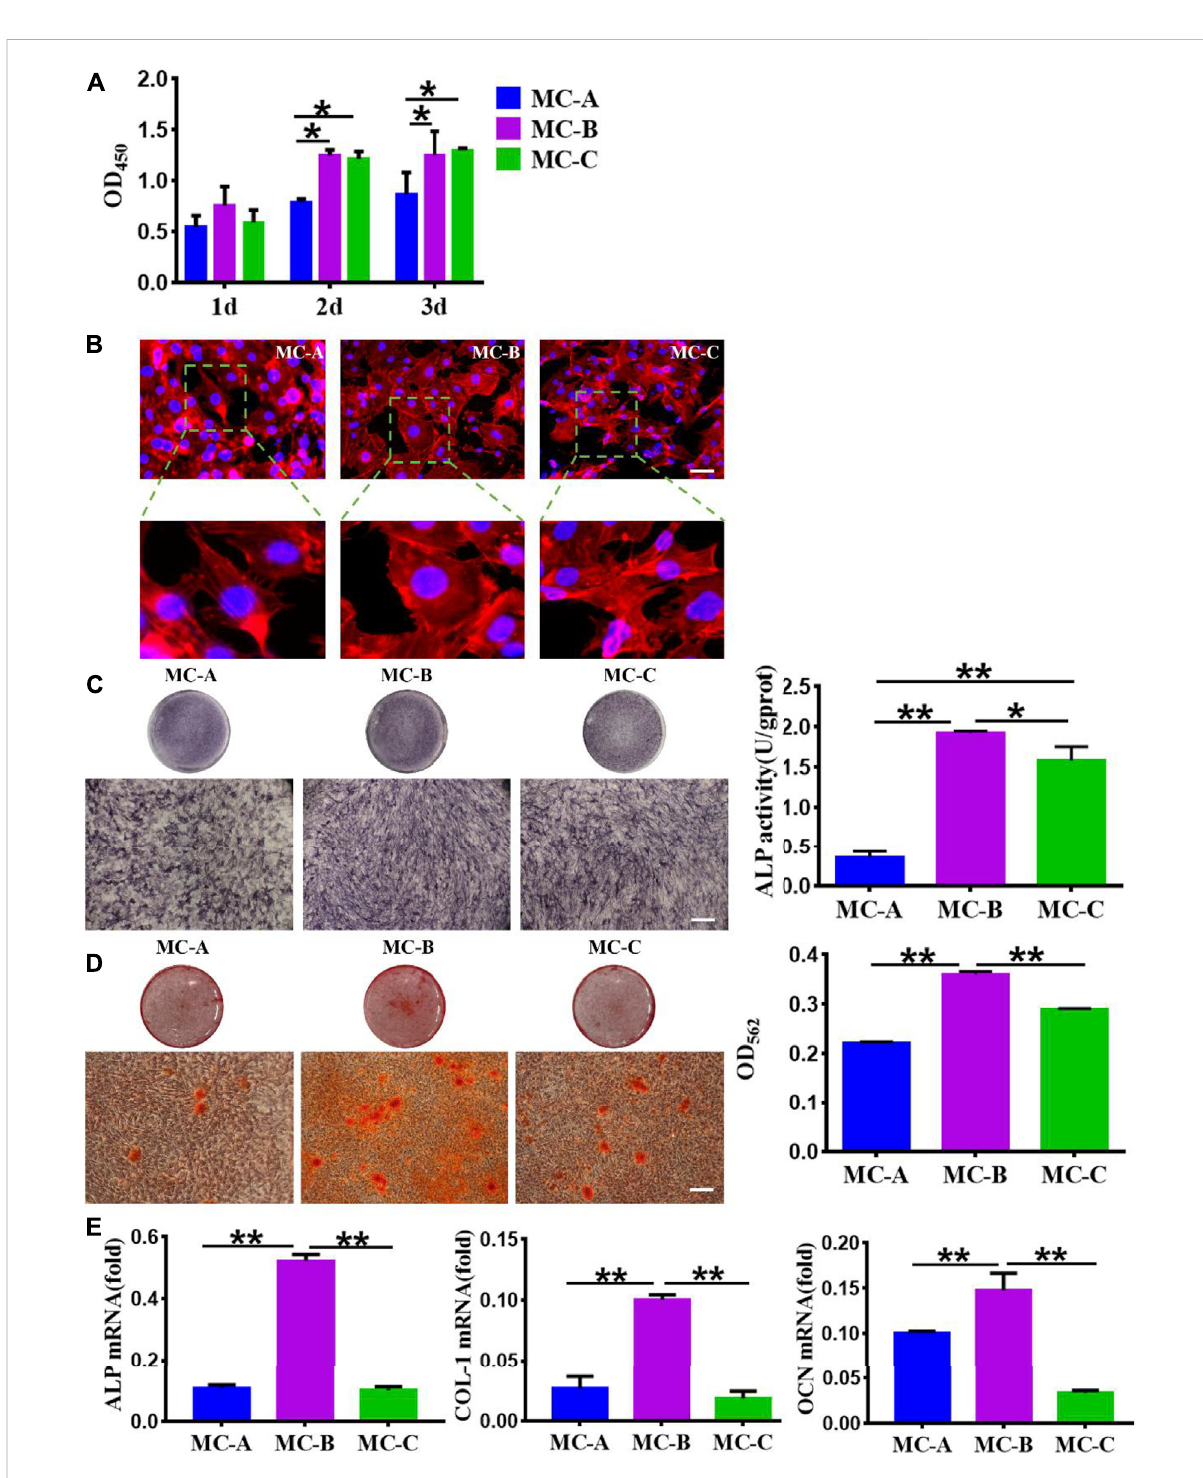
FIGURE 6 Effect of macrophage conditioned medium produced by mineralized collagen with different pore sizes on MC3T3-E1. (A) CCK-8 cell proliferation experimentation of MC3T3-E1 cells after cultured 1d, 3d, and 7 days in vitro ; (B) The cytoskeleton morphology of MC3T3-E1 cells cultured on different groups (scale bar: 50 μ m); (C) ALP staining and quanti fi cation in MC3T3-E1 cells (scale bars:100 μ m); (D) Alizarin red S staining andquanti fi cationinMC3T3-E1cells(scalebars:100 μ m); (E) TheexpressionofosteogenicgenewasdetectedbyqRT-PCR.Dataarepresented as mean ± SD. *p < 0.05; **p <